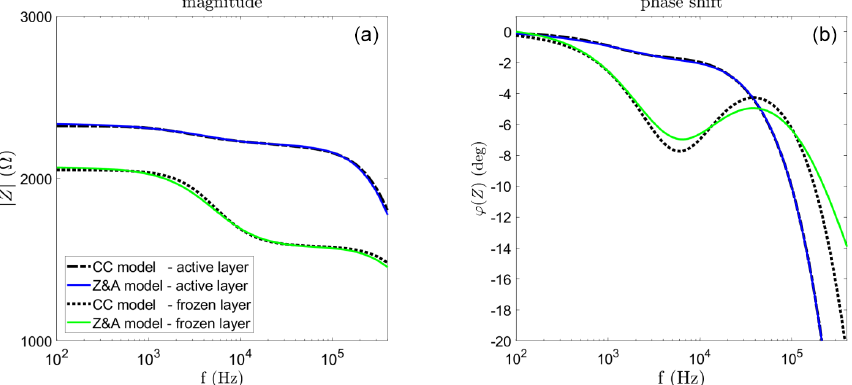
Figure 12. Spectra of the magnitude (a) and the phase shift (b) of the impedance Z by the single Cole–Cole model calculated by the AarhusInv 2-D inversion (dashed lines) and the fitted spectra after the model by Zorin and Ageev (2017) (coloured lines). The spectra represent exemplarily two different positions within the spacial range of the 2-D inversion, one from the unfrozen active layer (blue) and another within the permafrost layer in around 2m depth (green), which correspond to the cells outlined in red in Fig. 11.